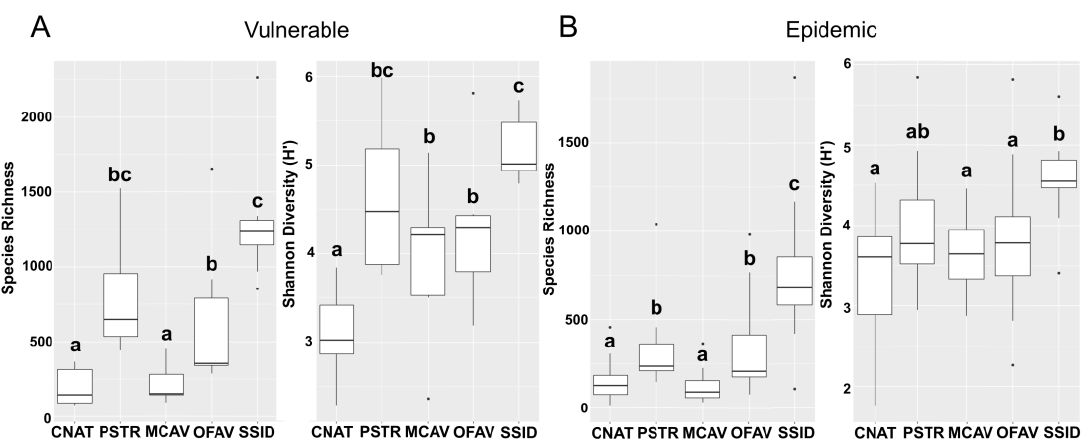
Figure 6. Microbial alpha diversity metrics (species richness and Shannon diversity) comparing tissue of apparently healthy colonies collected from five coral species, Colpophyllia natans (CNAT), Pseudodiploria strigosa (PSTR), Montastraea cavernosa (MCAV), Orbicella faveolata (OFAV), and Siderastrea siderea (SSID) in ( A ) the vulnerable zone and ( B ) the epidemic zone of stony coral tissue loss disease. Letters denote significant differences determined by the post hoc tests.